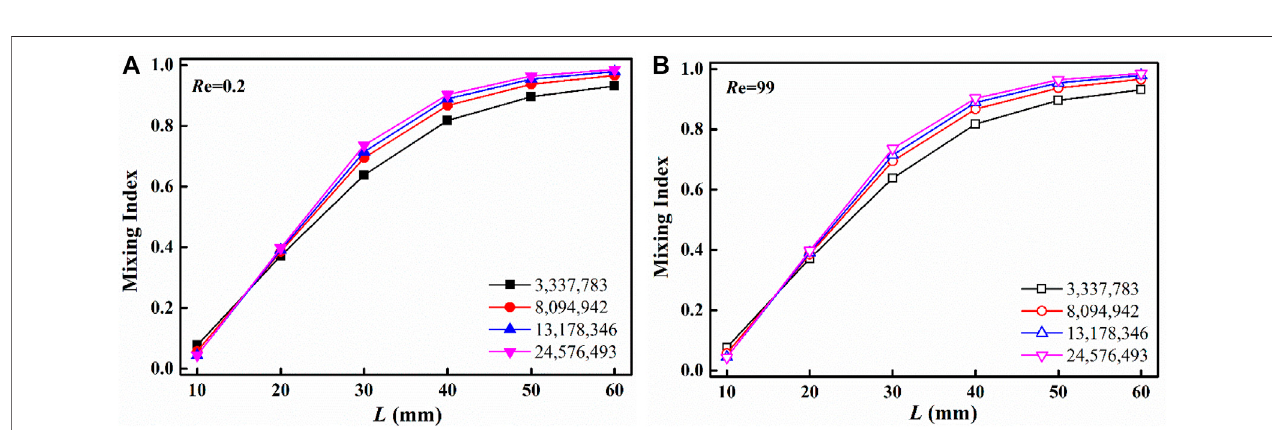
FIGURE 3 | Grid independency test: mixing index along the main channel (standard inserts with three layers): (A) R e (cid:1) 0.2 and (B) R e (cid:1) 99.